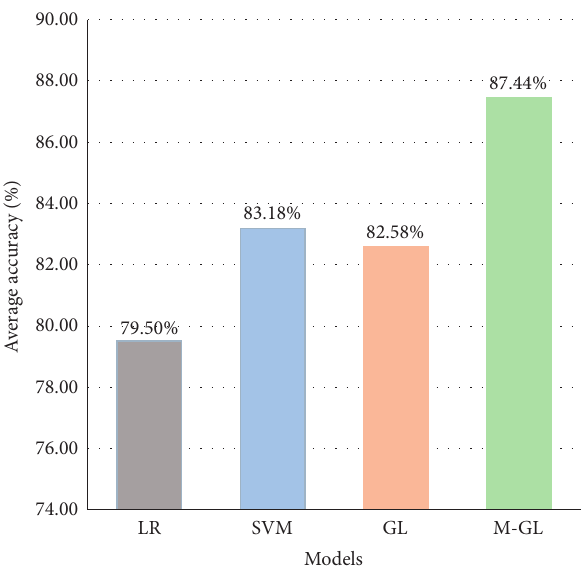
Figure 1: Average accuracy for different